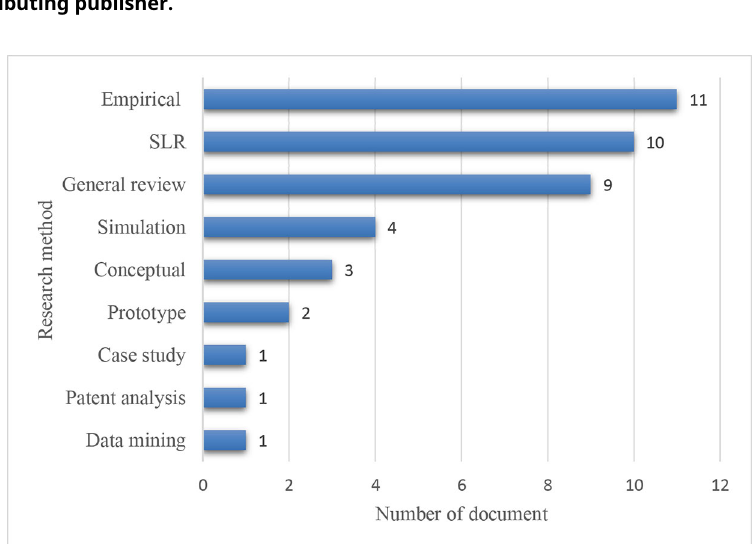
Figure 6. Contributing publisher.